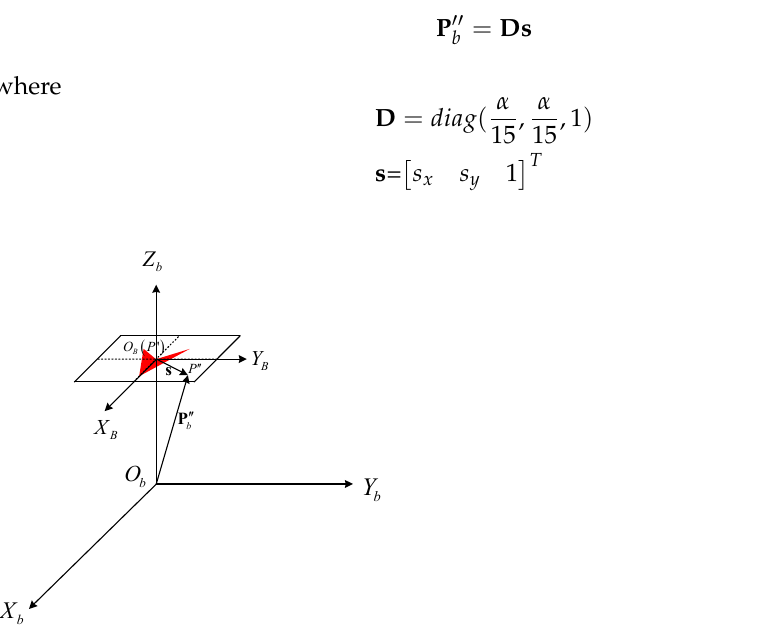
Figure 6. Coordinate mapping between BRIEF template coordinate system and feature point attitude coordinate